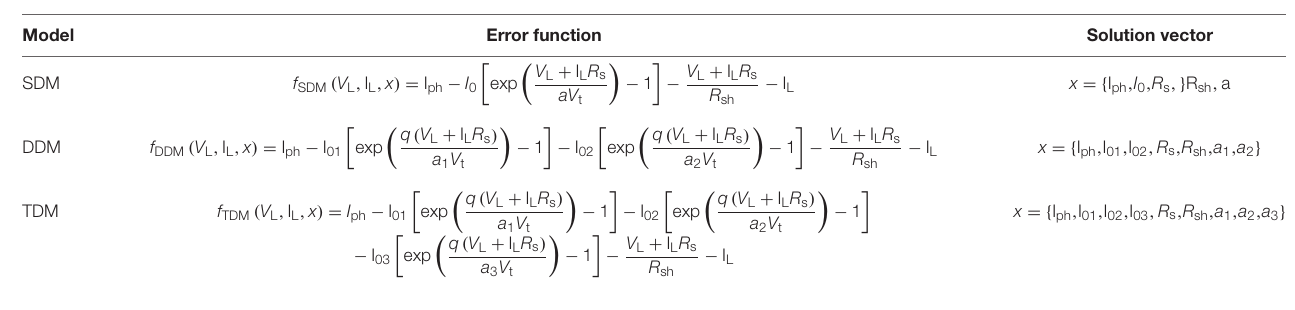
TABLE 2 | Error functions of three different